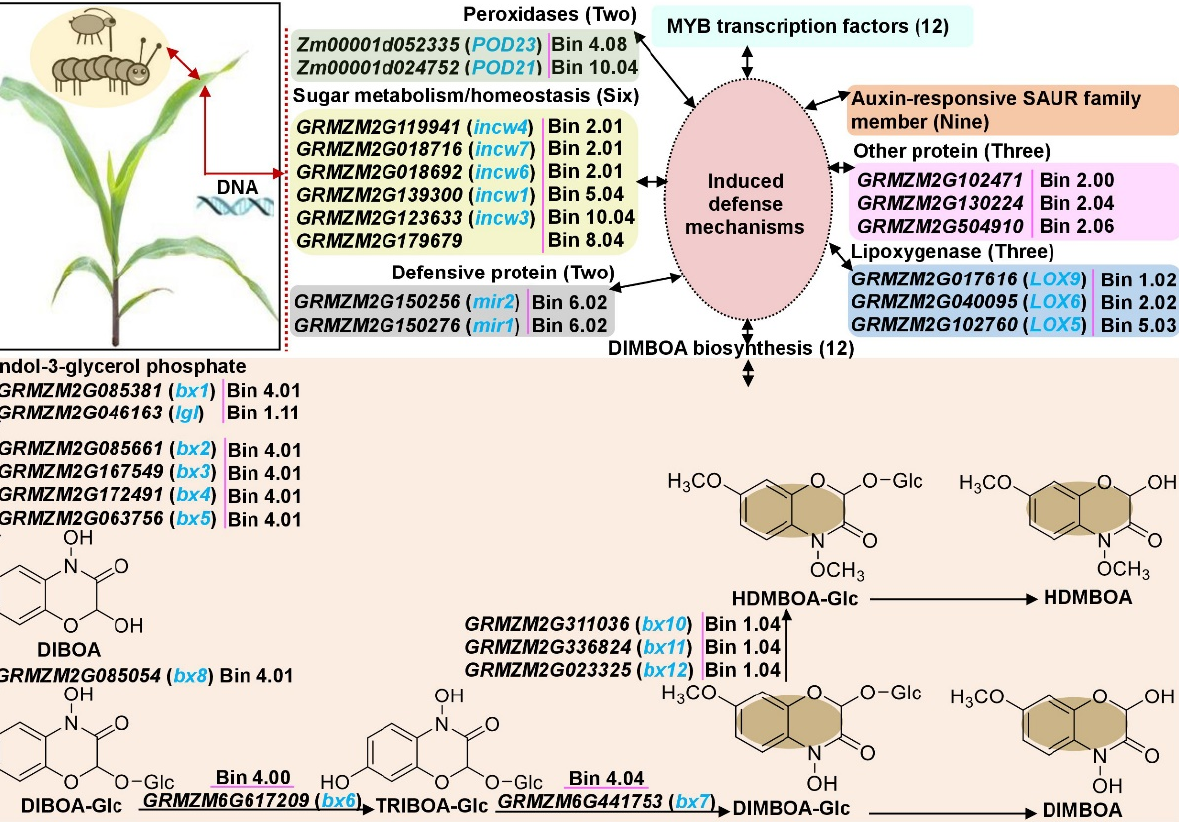
Figure 7. Molecular defense mechanisms underlying resistance to multiple insect pests of Asian corn borer (ACB) and corn leaf aphid (CLA) in maize. The synergy and antagonism of 49 candidate genes within 19 hot genetic loci formed the complex maize multiple insect pest-induced defense mechanisms, as well as DIMBOA biosynthesis pathway network.